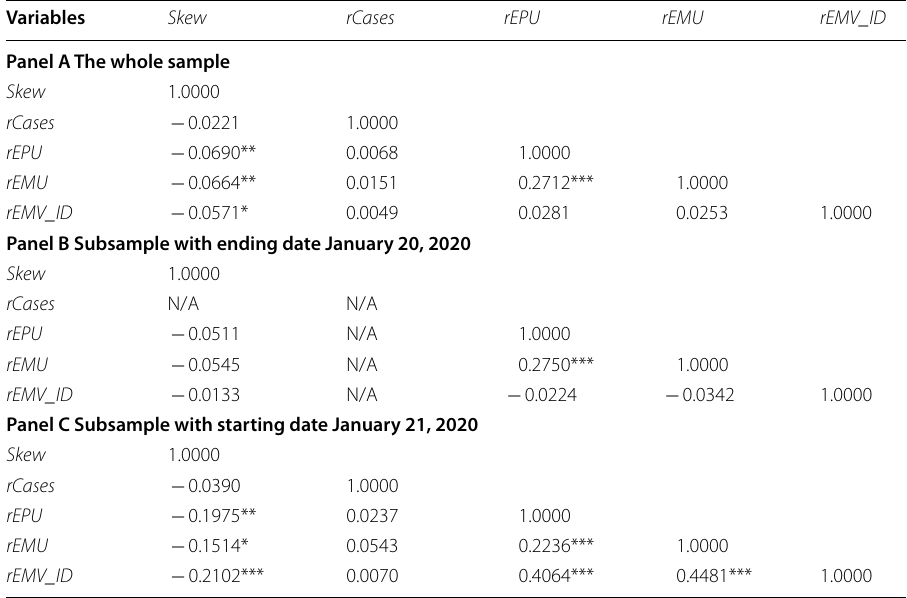
Table 3 Correlation matrix of the related